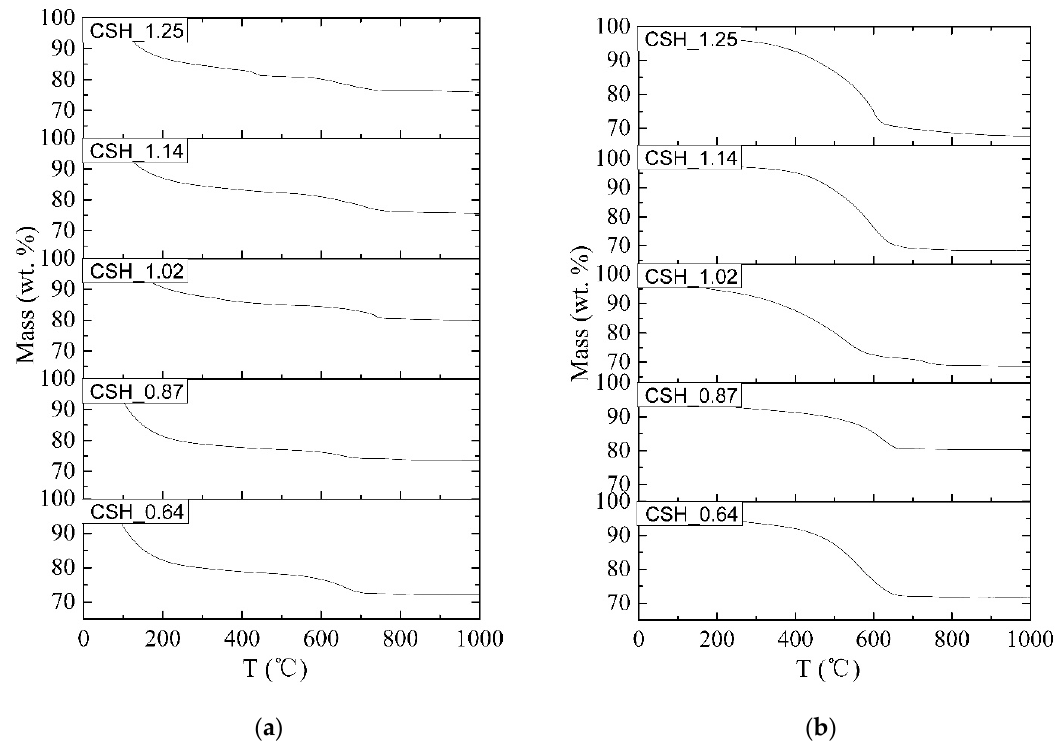
Figure 4. TGA patterns of C-S-H ( a ) before carbonation and ( b ) after carbonation for 28 days.